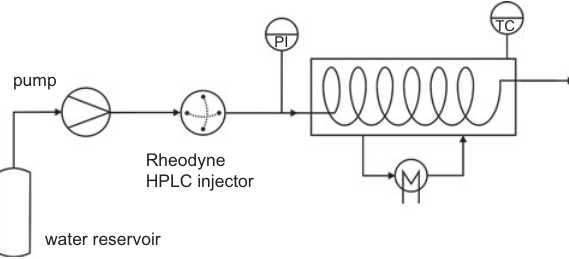
Figure 2 Set-up for the analysis of the residence time distribution.